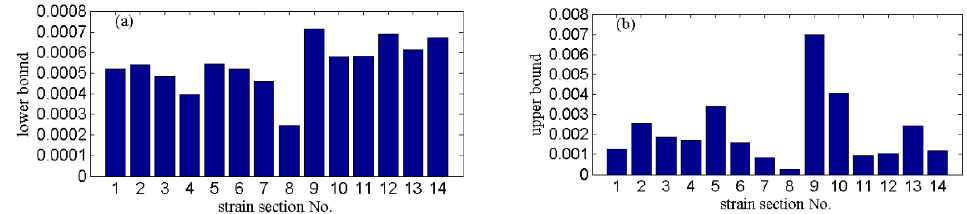
Figure 16. Failure bounds of each strain section. ( a ) the lower bound of failure probabilities; ( b ) the